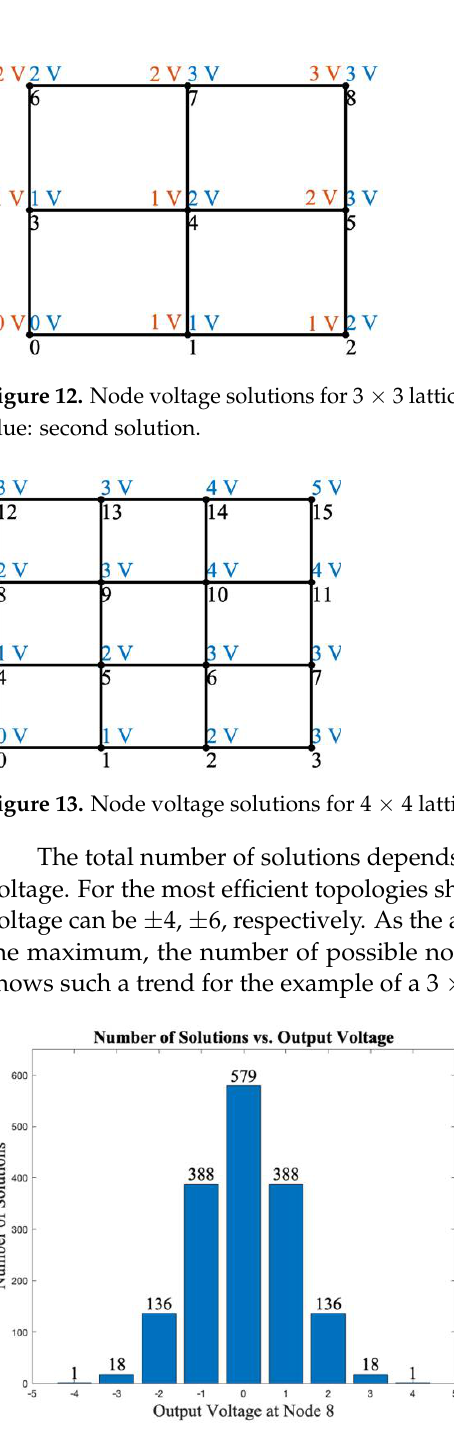
Figure 14. Number of solutions in relation to output voltage for 3 × 3 lattice converter shown in Figure 7.